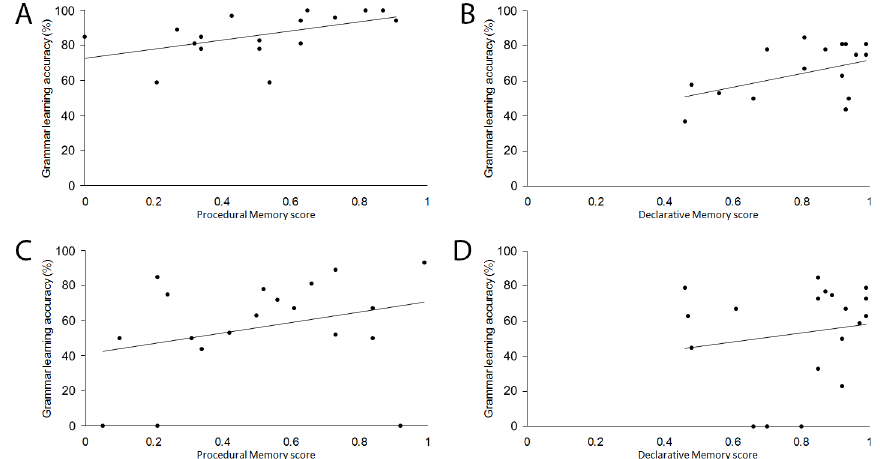
Fig 6. Scatterplots depicting correlations for the simple-complex training order between (A) procedural memory and simple grammar learning, and (B) declarative memory and complex grammar learning. For the complex-simple training order, procedural and declarative memory did not reliably correlate with simple or complex grammar learning (C and D, respectively).